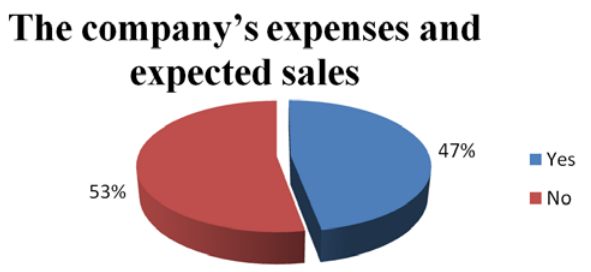
Fig. 6. The company’s expenses vs. expected